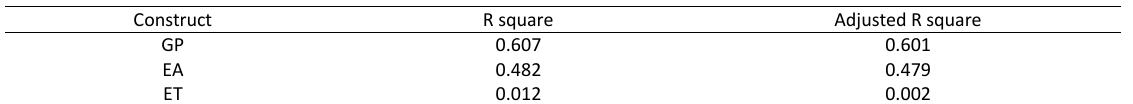
Table 6: R square (R 2 )